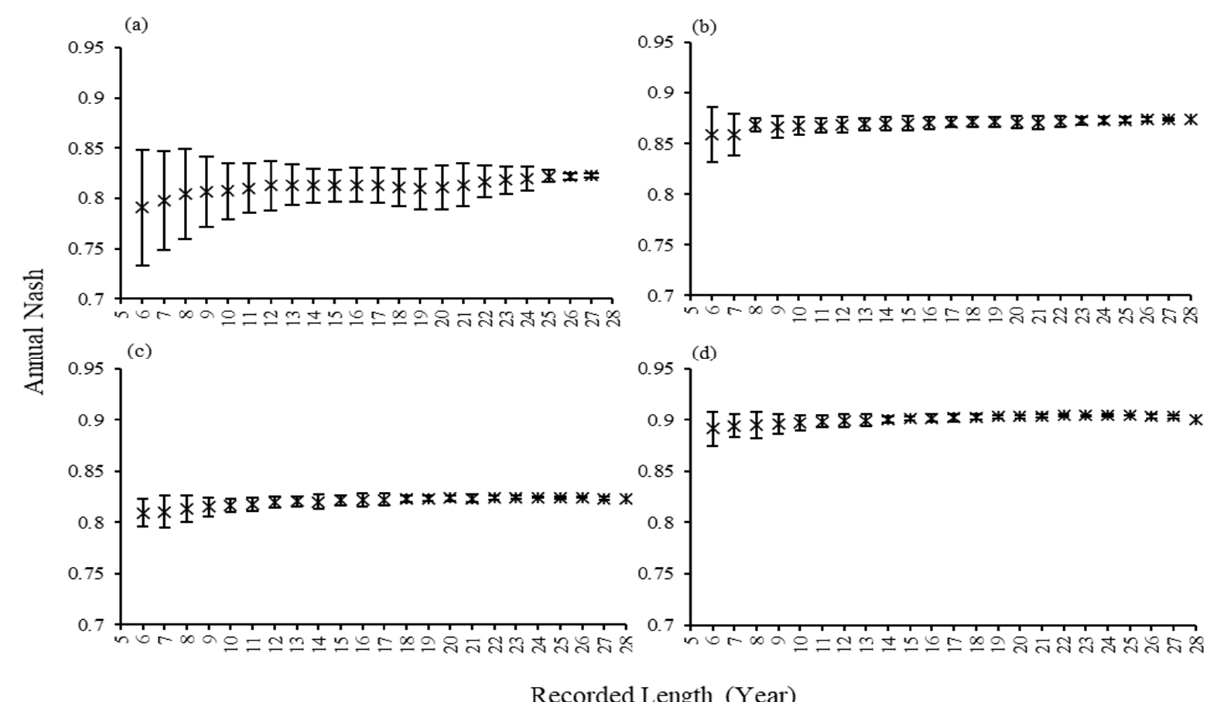
Figure 2. The values of annual Nash in all 28-year datasets for ( a ) Doki River Basin ( b ) MOPEX ID 3504000 ( c ) MOPEX ID 2387500 and ( d ) MOPEX ID 2448000.